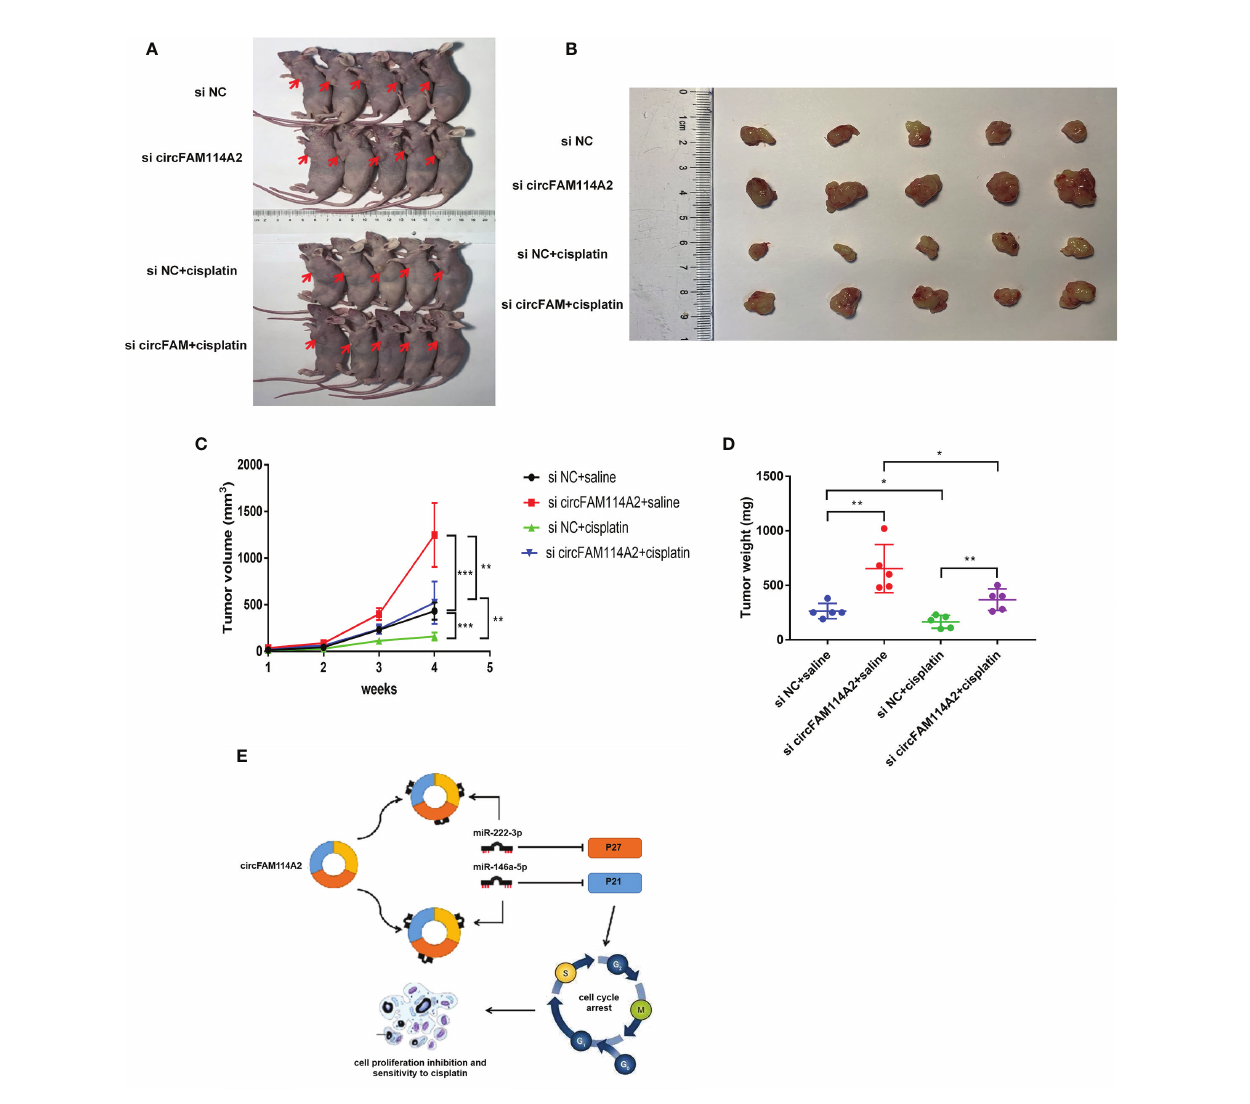
FIGURE 7 | CircFAM114A2 promoted cisplatin sensitivity in nude mice. (A) Representative image of nude mice injected with si circFAM114A2 or si NC transfection T24 cells, which were treated with cisplatin or saline ( n = 5). (B) Representative picture of the tumor formation of xenografts in nude mice injected with si circFAM114A2 or si NC transfection T24 cells, which were treated with cisplatin or saline ( n = 5). (C) The tumor volumes of nude mice were measured every week (Student ’ s t -test: ** p < 0.01, *** p < 0.001). (D) The weights of the tumors in the four groups were measured using electronic scales (Student ’ s t -test: * p < 0.05, ** p < 0.01). (E) Mode pattern of the circFAM114A2-miR-222-3p/miR-146a-5p-P27/P21 regulatory